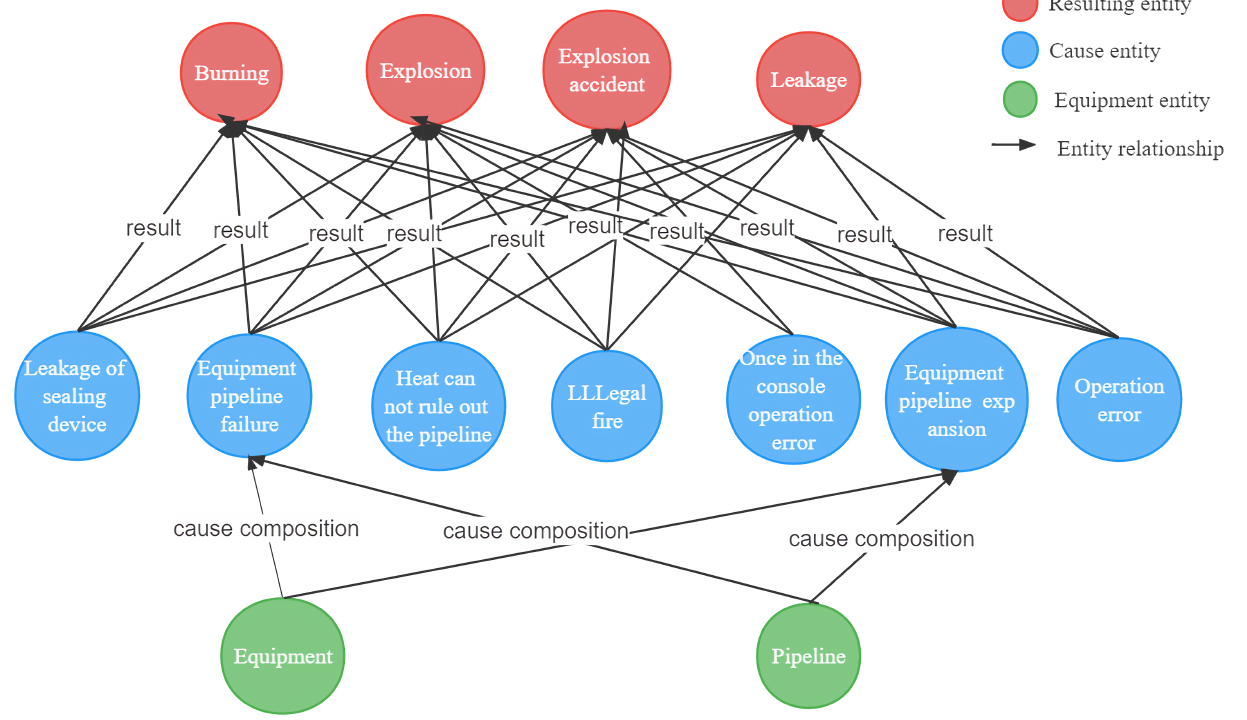
Figure 5. Standardized industrial safety knowledge graph structure.